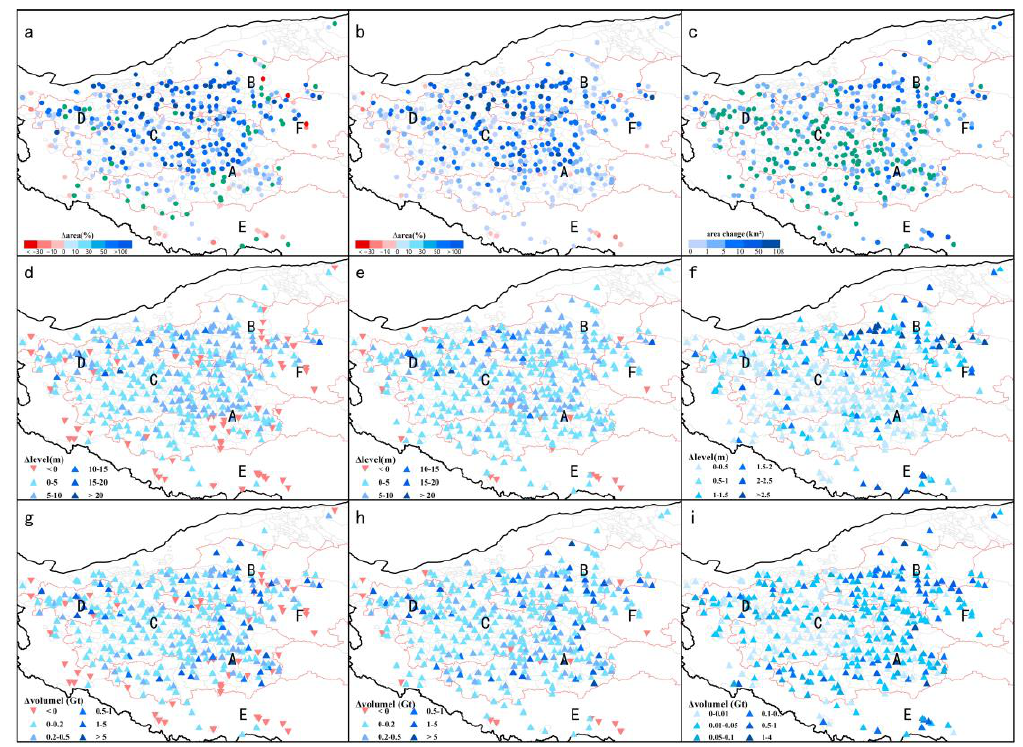
Figure 4. Variation and distribution of lakes on the TP from 2000 to 2018, A–F represent different sub-regions of this study. ( a ) the change of LA min ; ( b ) the change of LA max ; ( c ) the average annual change in lake area; ( d ) the average of LWLC min ; ( e ) the average of LWLC max ; ( f ) the average annual change in LWL; ( g ) the LWSC min ; ( h ) the LWSC max ; ( i ) average of LWSC intra-year .